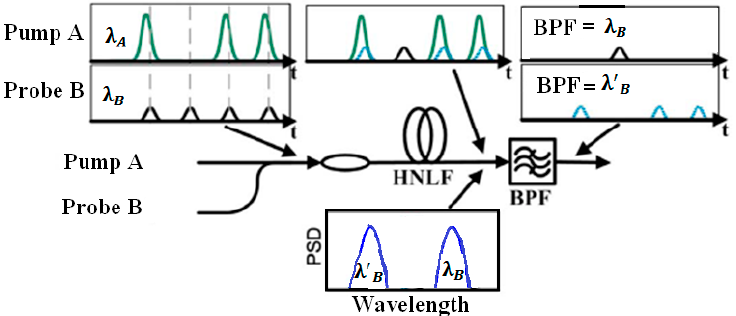
Figure 1. Different stages for the propagating pump and probe in HNLF.